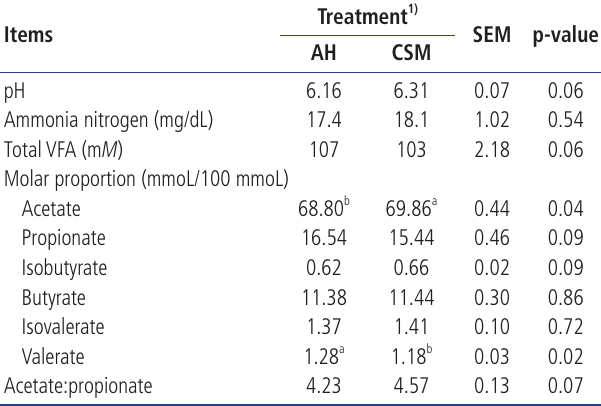
Table 3. Ruminal fermentation variables in dairy cows fed experimental diets Items